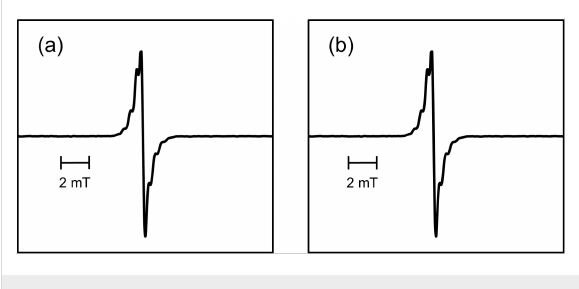
Figure 5: ESR spectrum of fractured sample of Dx and TCNE (a) before and (b) after visible-light irradiation.